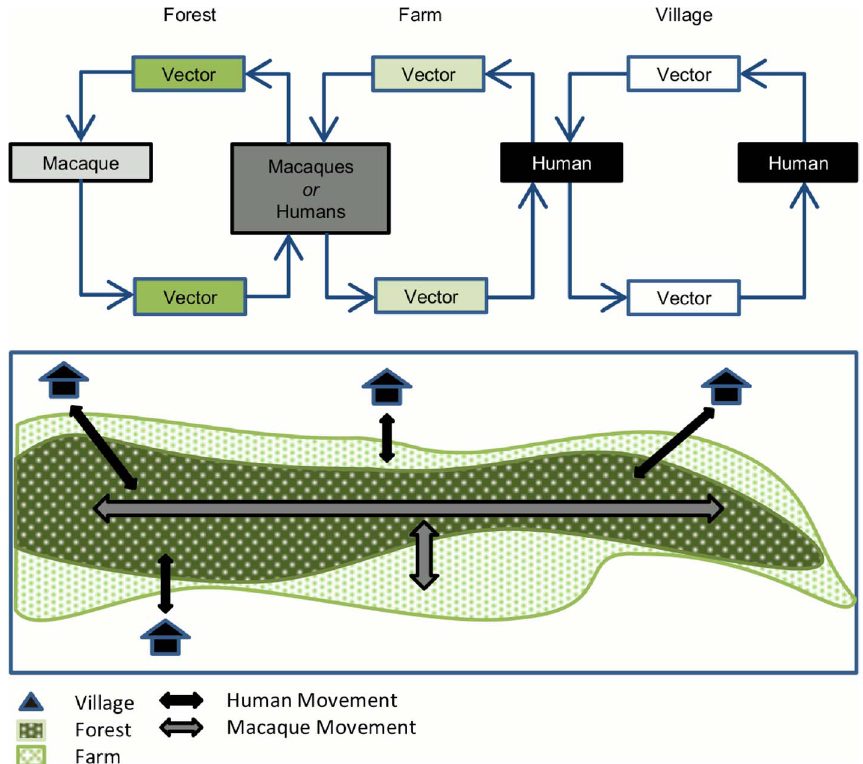
Figure 1. Distribution of forest, farm, villages, and the movement of macaques and humans between the 3 areas, and the hypothesised transmission cycle of Plasmodiumknowlesi in Malaysia and Southeast Asia. Adapted from the yellow fever transmission cycle observed in Africa [52]. For clarity in notation, the forest will be referred to as the jungle ( J ), to differentiate from the farm ( F ) in later equations and model